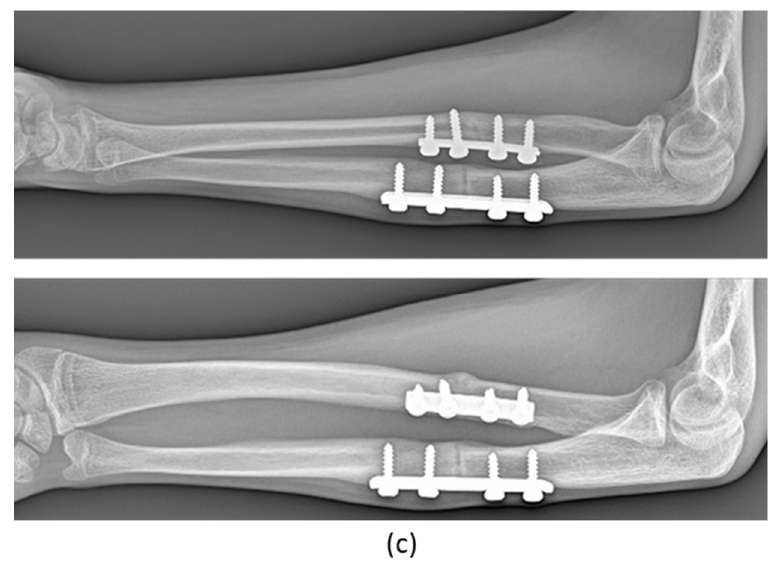
Figure 11. Antero-posterior and lateral X-Ray of the affected forearm after surgery ( a ), two months later ( b ), and at the last control, five months after surgery ( c ).